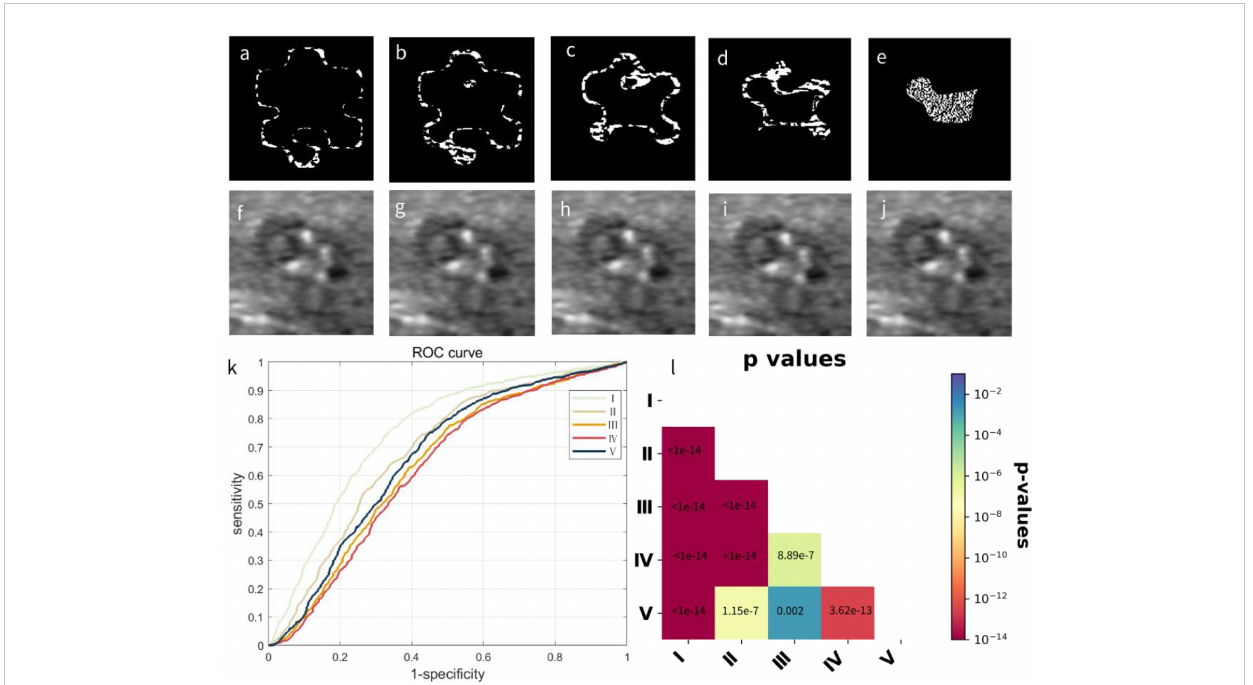
FIGURE 3 Adding noise perturbations to fi ve regions from the outermost area to the innermost area of equal sizes in the original image and their in fl uence on classi fi cation performances. (A – E) The generated gradient sign noise images. (F – J) The perturbed images with noises with magnitude b of 0.0136 (identi fi ed as the point where the overall AUC values decay the fastest as measured by absolute gradient) added to each corresponding region. (K) ROC curves calculated from the complete dataset with nodular regions separately perturbed by noises in regions I to V represent the outermost to innermost nodular regions. (L) The associated p-value matrix for statistical comparisons. All p-values were ≤ 0.002, and p-values lower than 1 × 10 − 14 were shown as 1 × 10 − 14 . Self-comparisons were omitted, as they were constant at 1. AUC, area under the curve; ROC, receiver operating characteristic.